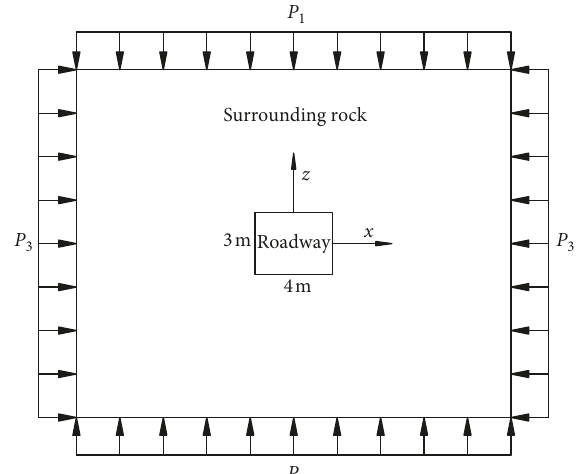
Figure 1: Stress model of the surrounding rock a roadway in the regional stress